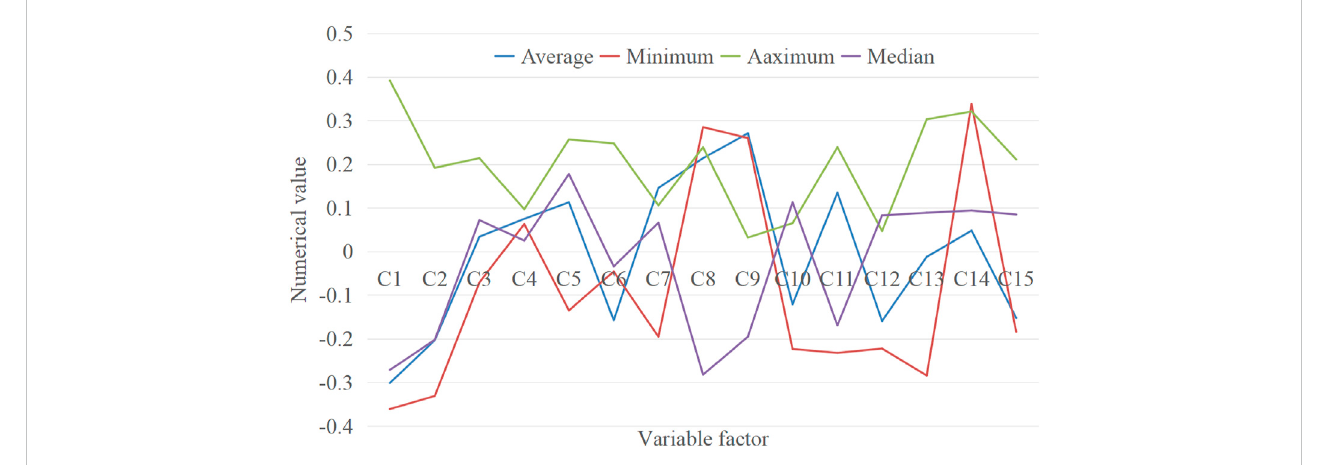
FIGURE 5 Overall distribution of variables.